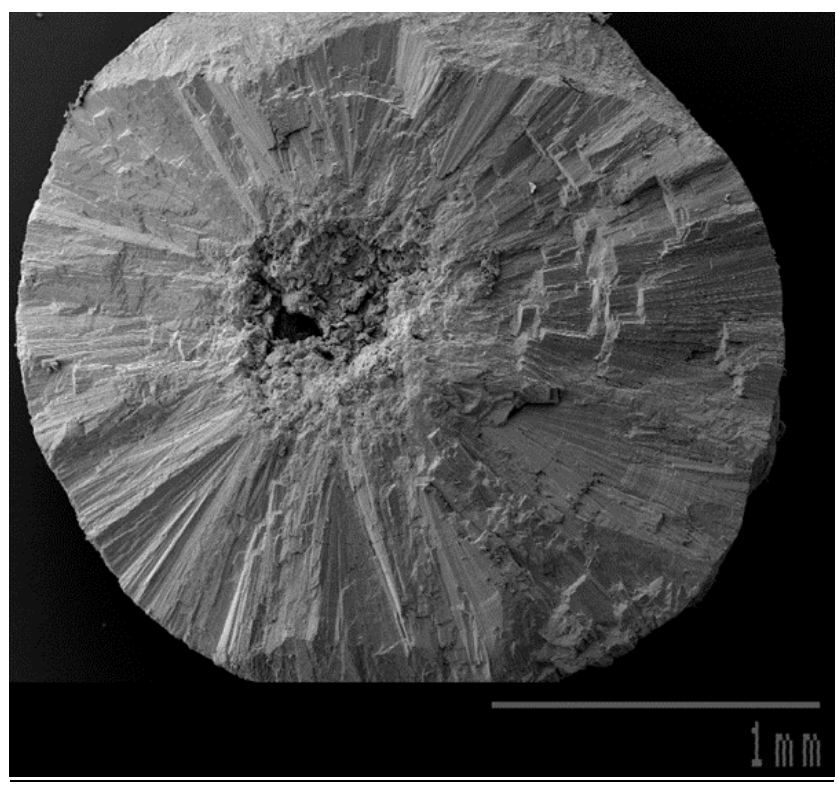
FIGURE 2. Scanning electron microscopy image of a COM nonpapillary calculi consisting of a central core surrounded by compact columnar COM crystals emerging from it.